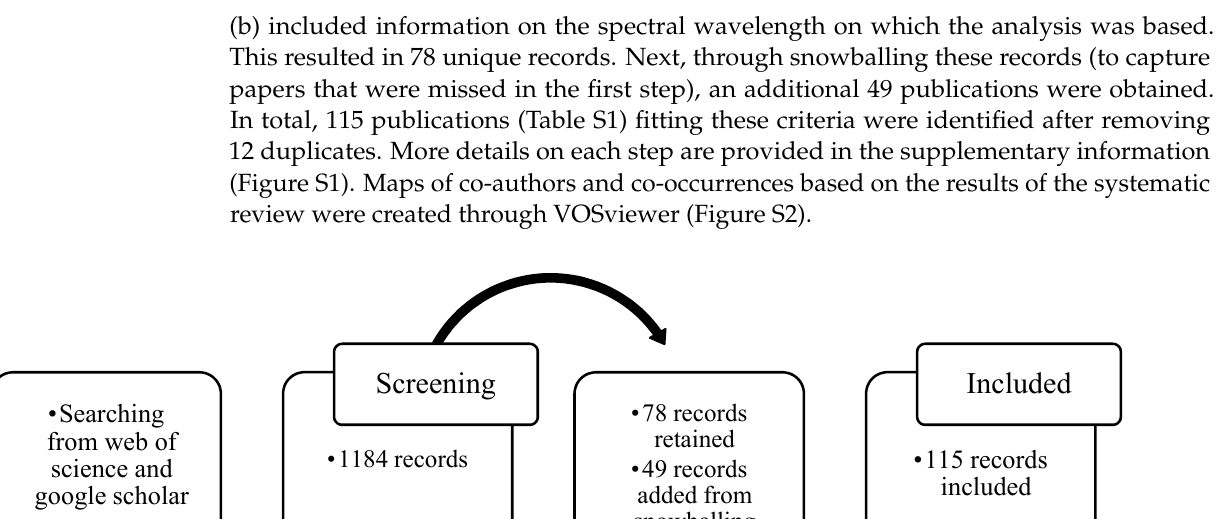
Figure 2. Flowchart of the systematic review.